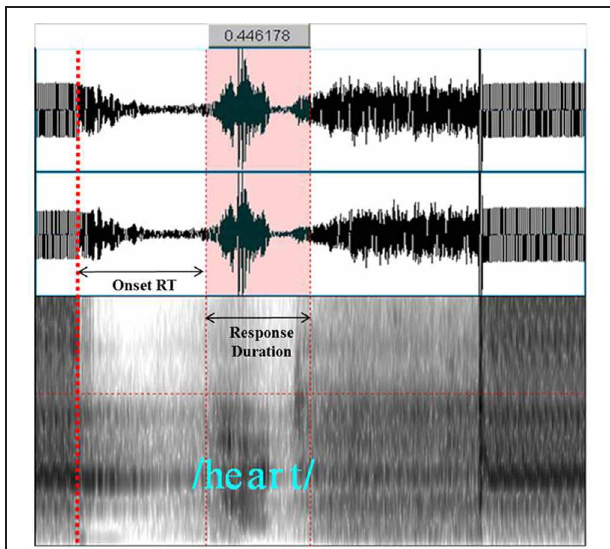
FIGURE 5 | An example of using PRAAT to assist in localizing the onset RT and RD of the vocalization “heart.” Offset of gradient noise from the MRI can be seen and heard at the time point of the coarse red-dashed line (relevant for Experiment 1 only). The onset and offset of the vocalization can be seen and heard between the thin red-dashed lines, while the temporal distance between those lines (i.e., the RD) is indicated at the top. Visual inspection of both the spectrograms and the formants, as well as several replayings of the audio recording, allowed for precise measurement of the onset RT and RD.